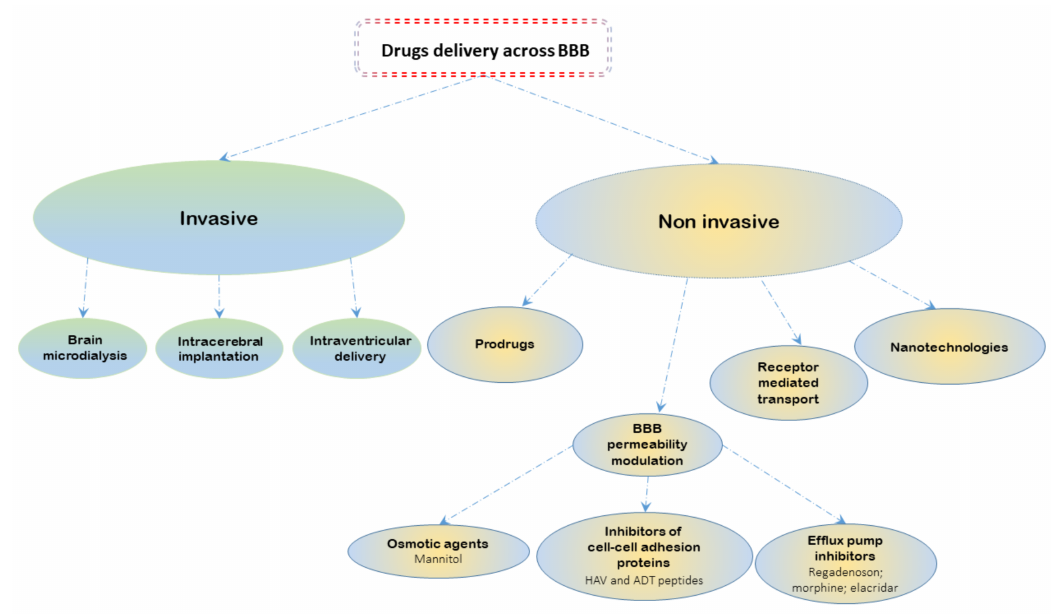
Figure 2. Schematic representation of the most used approaches to overcome the BBB-mediated